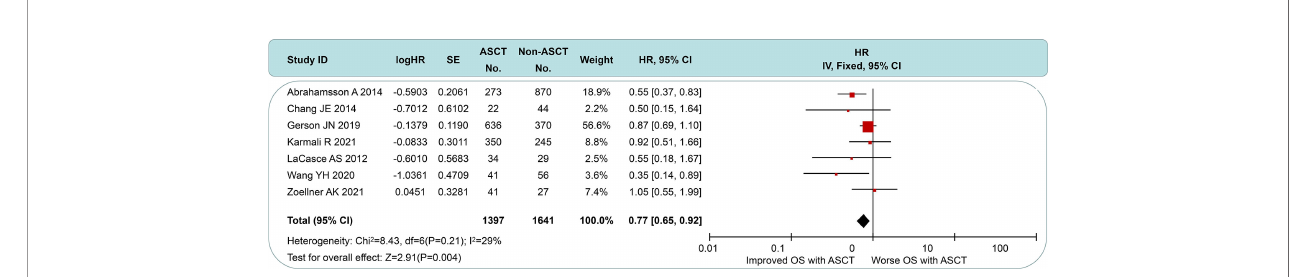
FIGURE 5 | Forest plot and meta-analysis of overall survival between the ASCT and non-ASCT group in MCL patients. ASCT, autologous stem cell transplantation; MCL, mantle cell